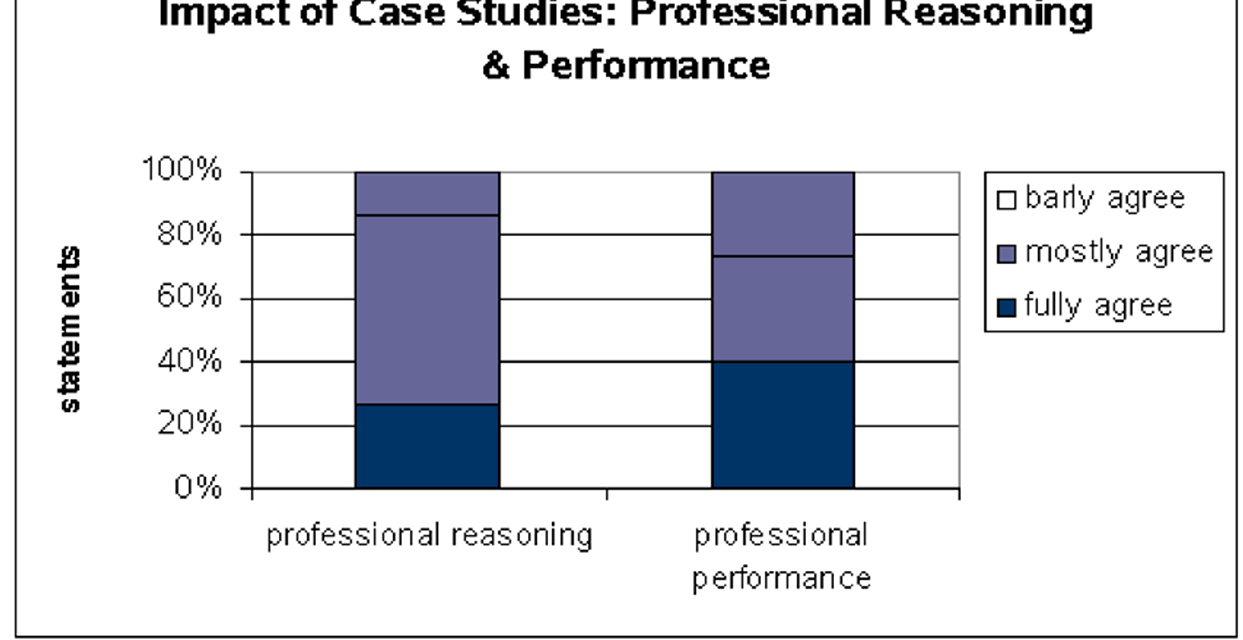
Figure 4 Impact of Case Studies: Professional Reasoning & Performance.